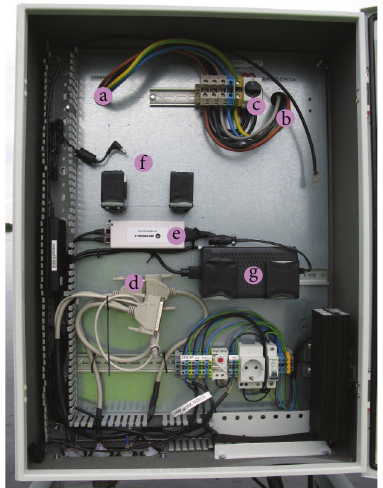
Figure 7: Interior of the bridge enclosure. Power from the generator (a) and to the control station (b) can be manually short circuited in (c). Hall sensor and other signals are relayed in (d). (e) provides power for the network camera. A computer for communication with ADCPs will be mounted (f) and the ADCPs need power (g).